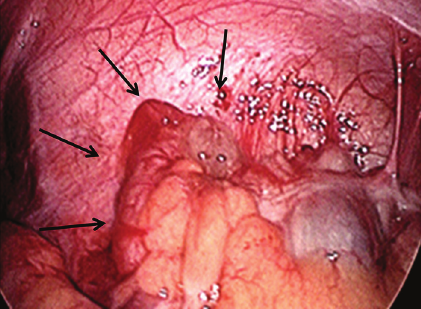
Figure 2: Intraoperative findings: periappendicitis and acute in- flammation of the appendix with mucinous